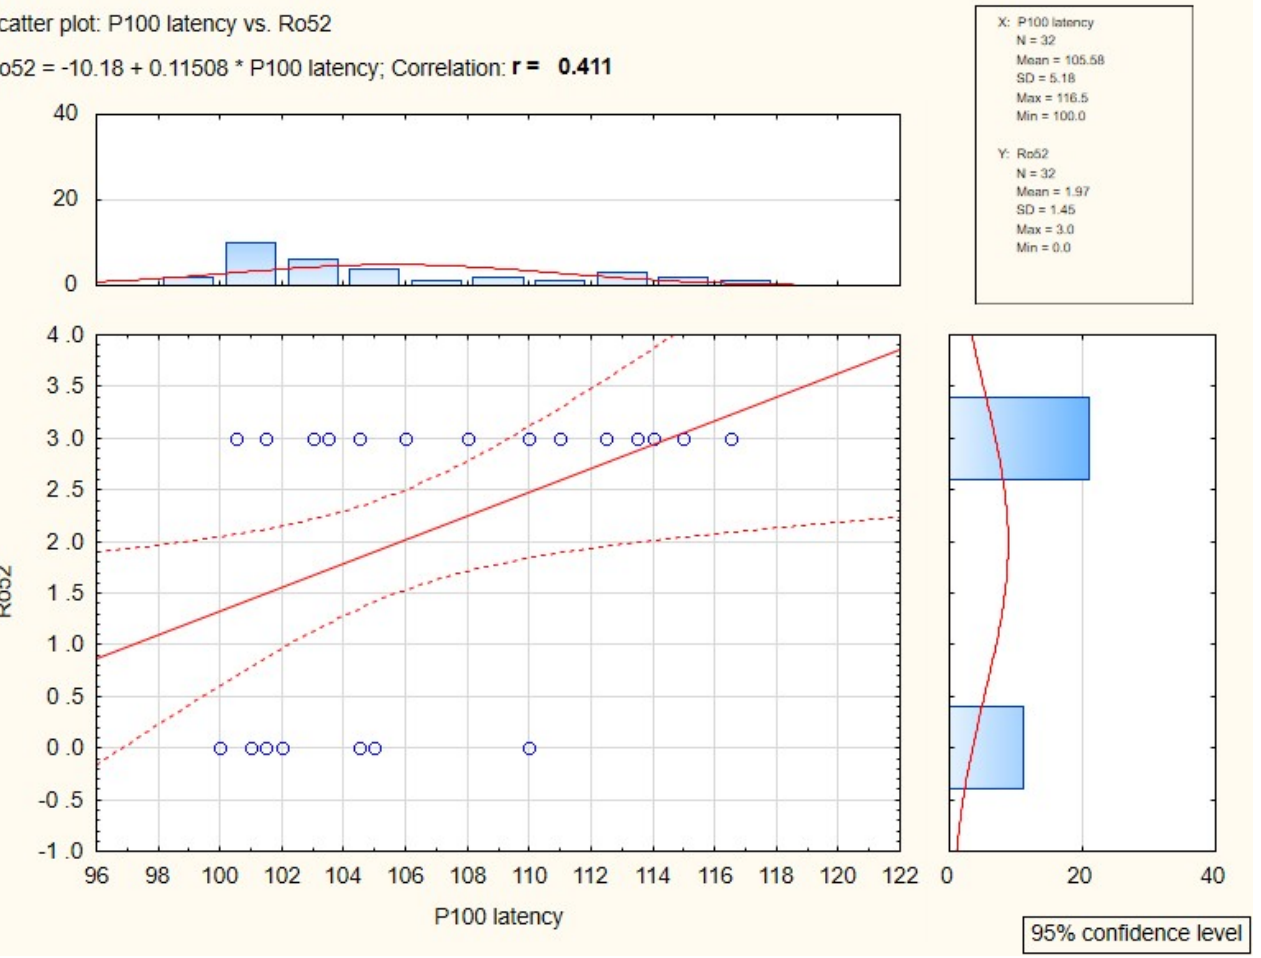
Figure 2. Diagram of correlation between anti-Ro52 antibodies and P100 implicit time value.